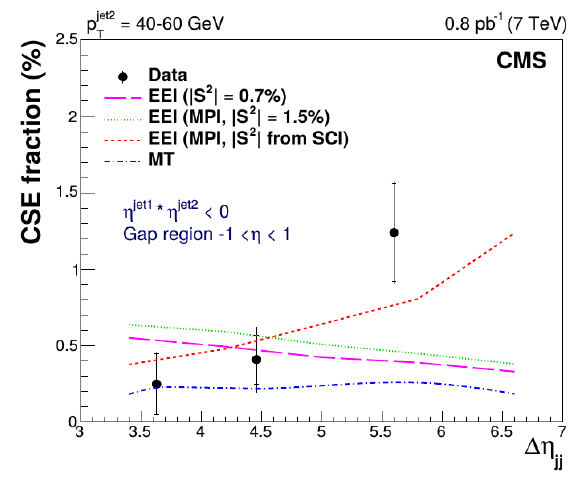
Figure 3. The fraction of colour singlet exchange in events with two jets, see Ref. [4], as function of the jet-separation ∆ η jj .